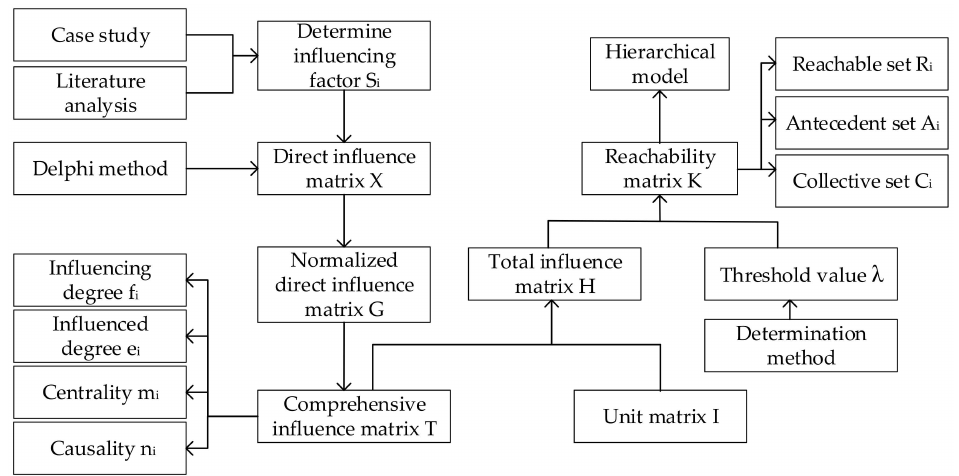
Figure 1. The framework of Interpretive Structural Modeling and Decision Making Trial and Evaluation Laboratory (ISM-DEMATEL)